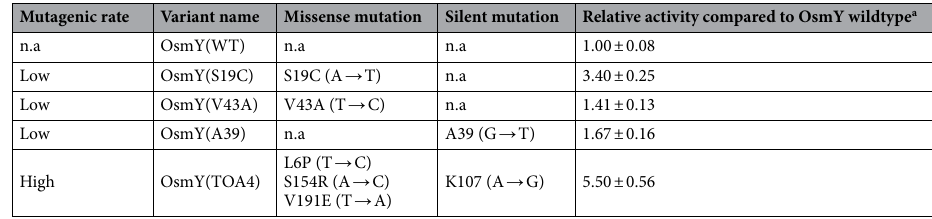
Table 1. OsmY variants identified from screening of epPCR libraries. The mutations were verified by DNA sequencing. a Variants were cultivated in 5-mL tubes cultures and activity of extracellular OsmY-Tfu0937 was determined with the pNPG assay using an absorbance at 405 nm, and compared with the wildtype OsmY-